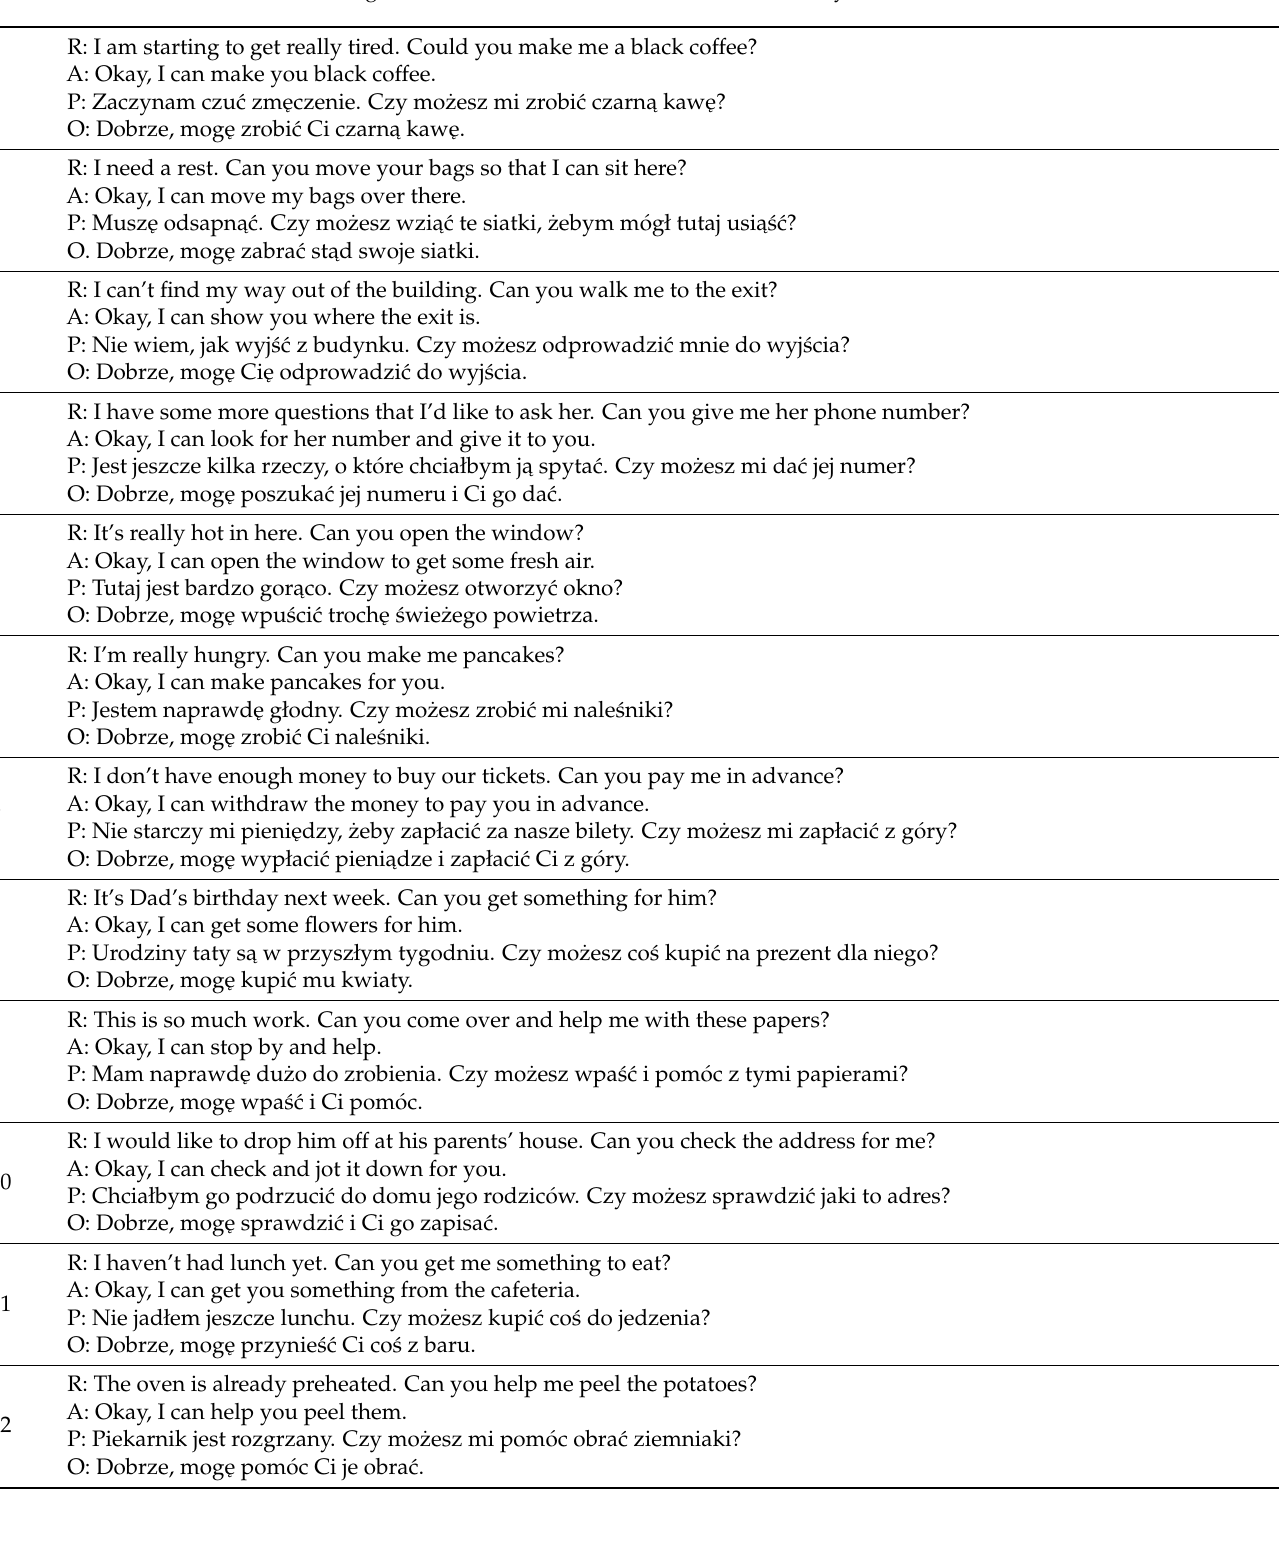
Table A2. Requests and answers that were used as stimuli for testing perceived willingness of the respondents to grant the requests. The mini-conversations are presented in English translations and the original Polish versions that were used in the